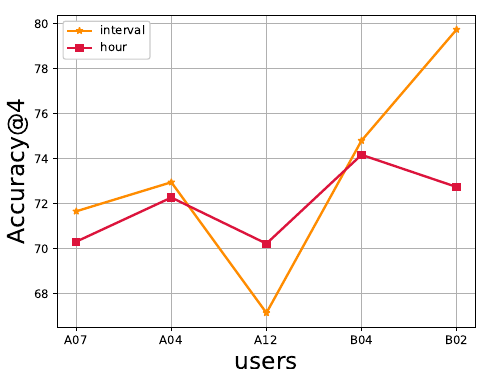
Figure 6. The comparison of two types of time patterns with prediction Accuracy @4 of five users: interval of day , hour of day .